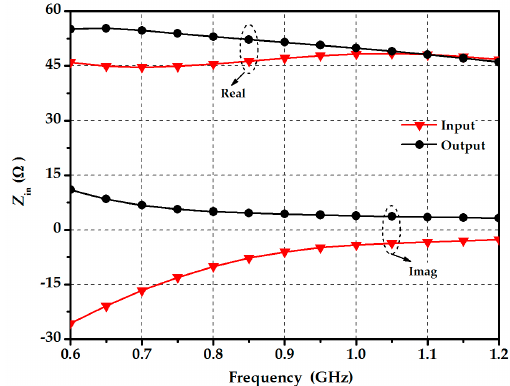
Figure 6. Impedance curves of the amplifier matched with the proposed method.